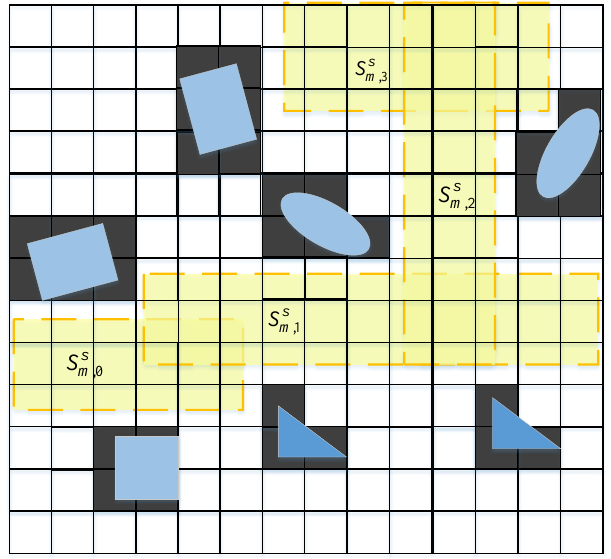
Figure 1. Static-layer corridors For the k th static-layer corridor tion (18).